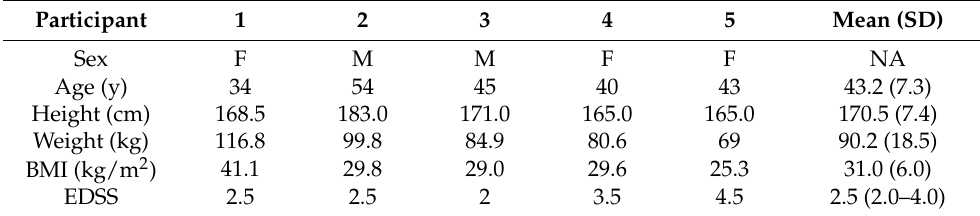
Table 1. Participant Characteristics (N = 5).